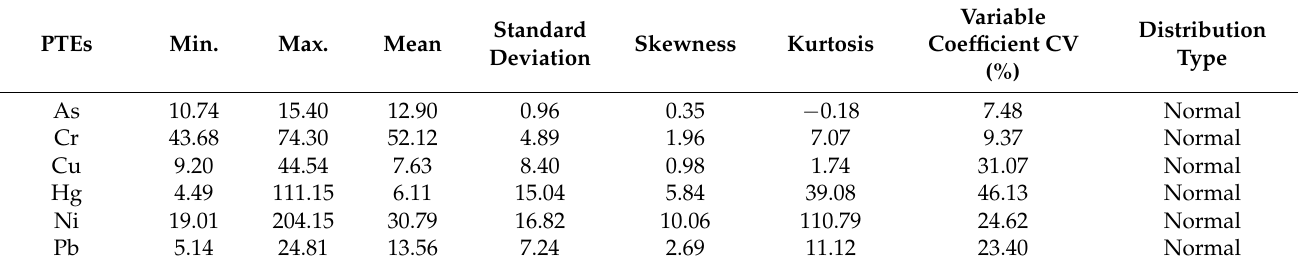
Table 6. Statistics of PTE concentrations in soil samples (mg/kg).